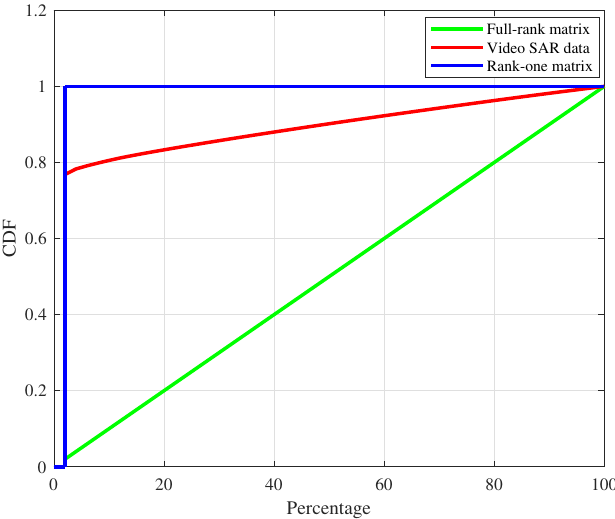
Figure 3. Low-rank property analysis for video SAR data by using cumulative distribution function (CDF) to data matrix O